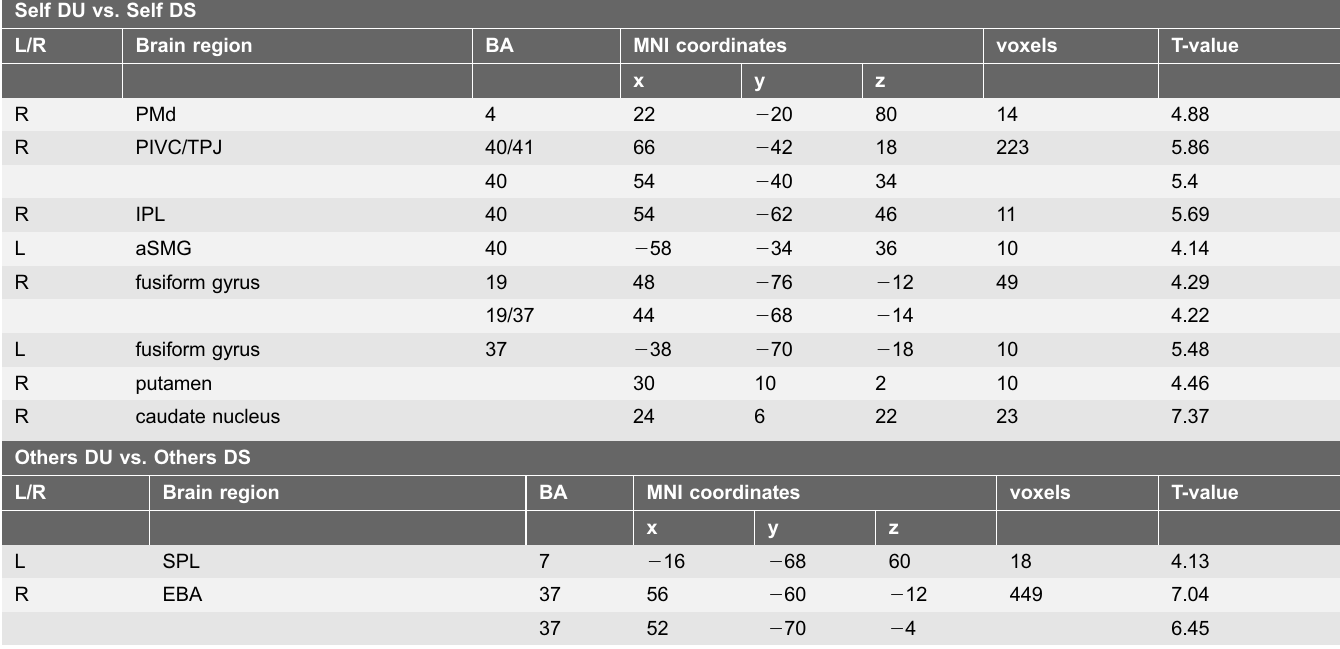
Table 2. Brain activity in the DU vs. DS contrast for self and others. Self DU vs. Self DS